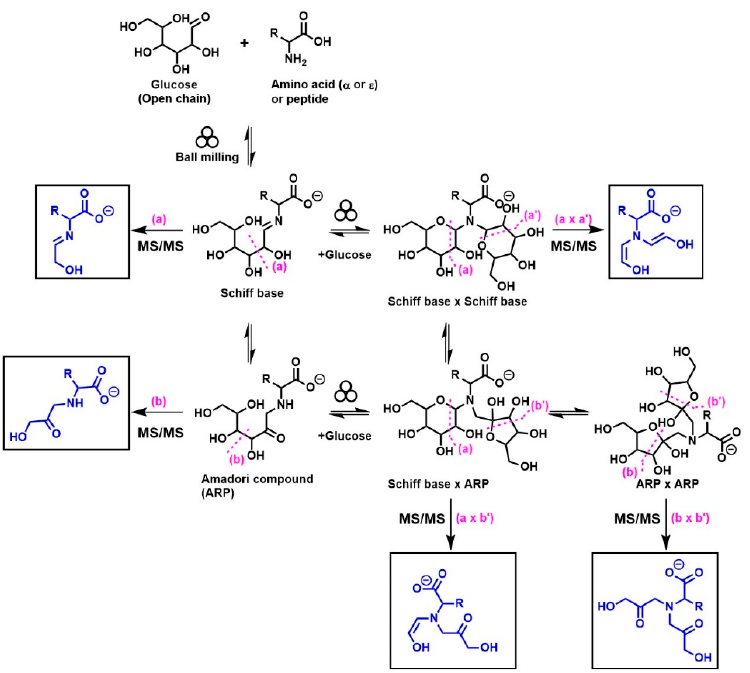
Figure 1. Structures of the MS/MS diagnostic ions (shown in square boxes) generated under negative-mode ESI that have been utilized for the identification of different isomers of monoglycated and diglycated amino acids. The specific tautomeric forms shown in the figure are for clarity only.